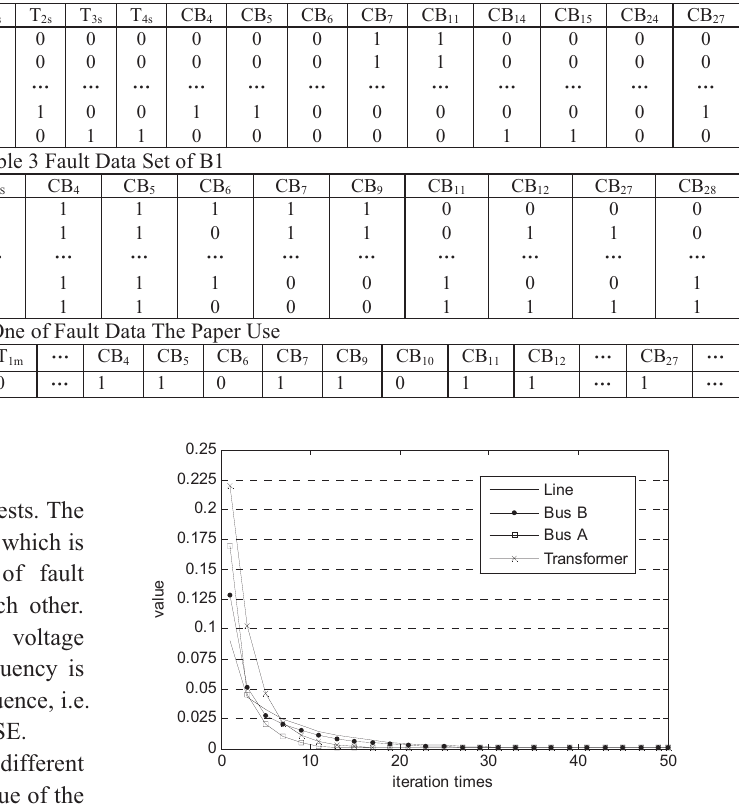
Table 2 Fault Data Set of L1